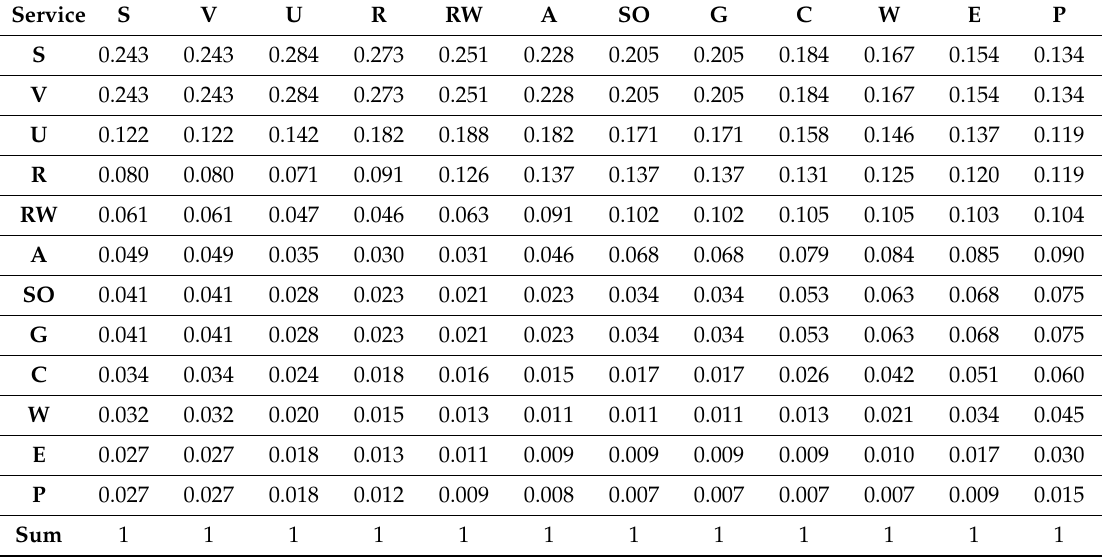
Table 5. The percentages of the preferences values using the AHP